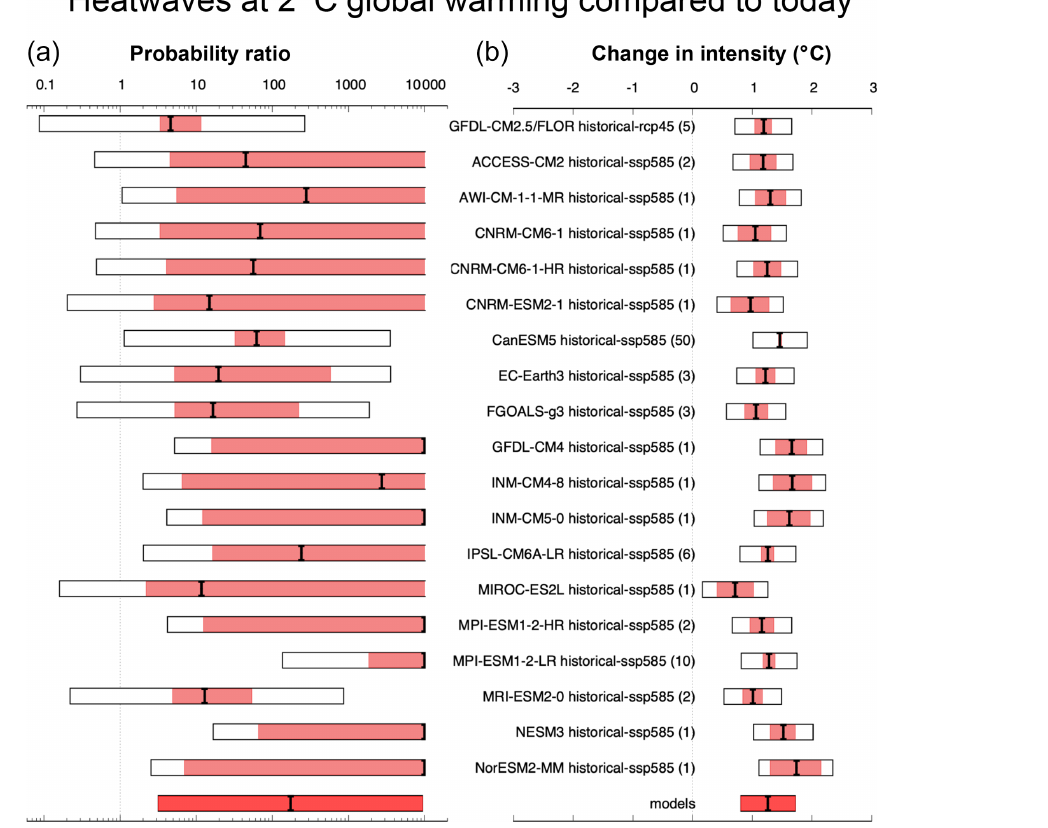
Figure 13. Same as Fig. 12 but comparing 2 ◦ C of global warming (above pre-industrial) with present-day values (models only).